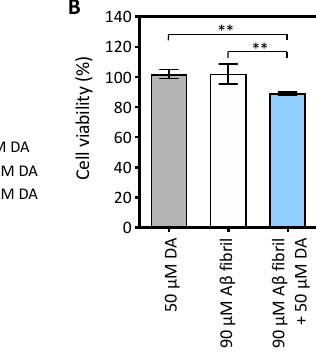
Figure 2. ( A ) Normalized Thioflavin T (ThT) fluorescence intensity during fibril disaggregation in the presence of different molar ratios of dopamine (DA). The fluorescence intensity of amyloid β (A β ) fibrils without compounds at 0 h is indicated as 100%. The mean ± standard deviation (SD) is shown on the graph (N = 3). The fluorescence data of 90 µ M A β fibrils alone are the same